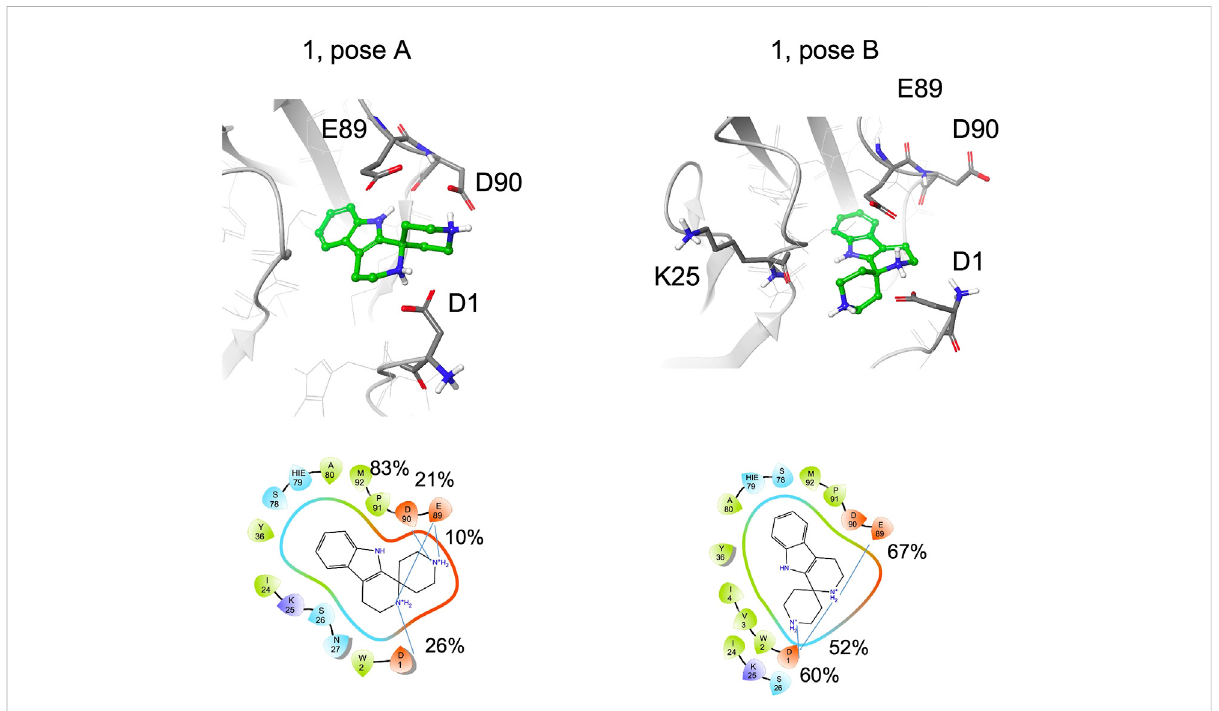
FIGURE 8 Snapshots from MD simulations for 1 (pose A and B). The corresponding 2D ligand interaction diagram and percentages of salt bridges monitored during the MD simulations are also